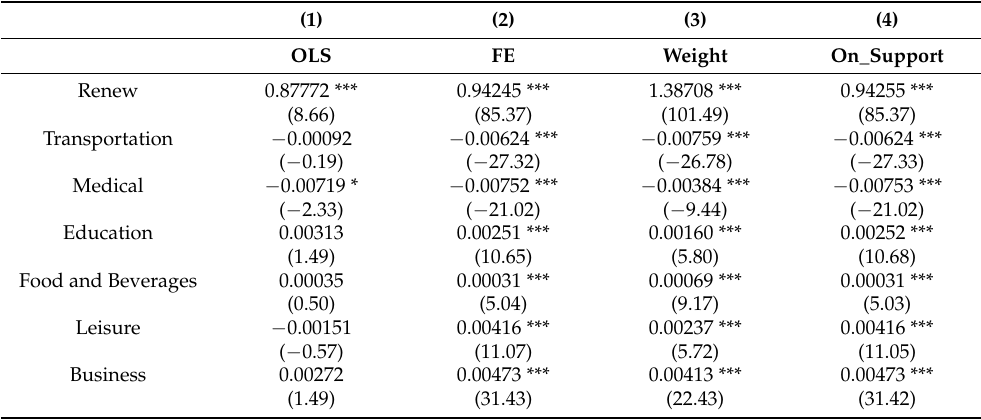
Table 3. Results of